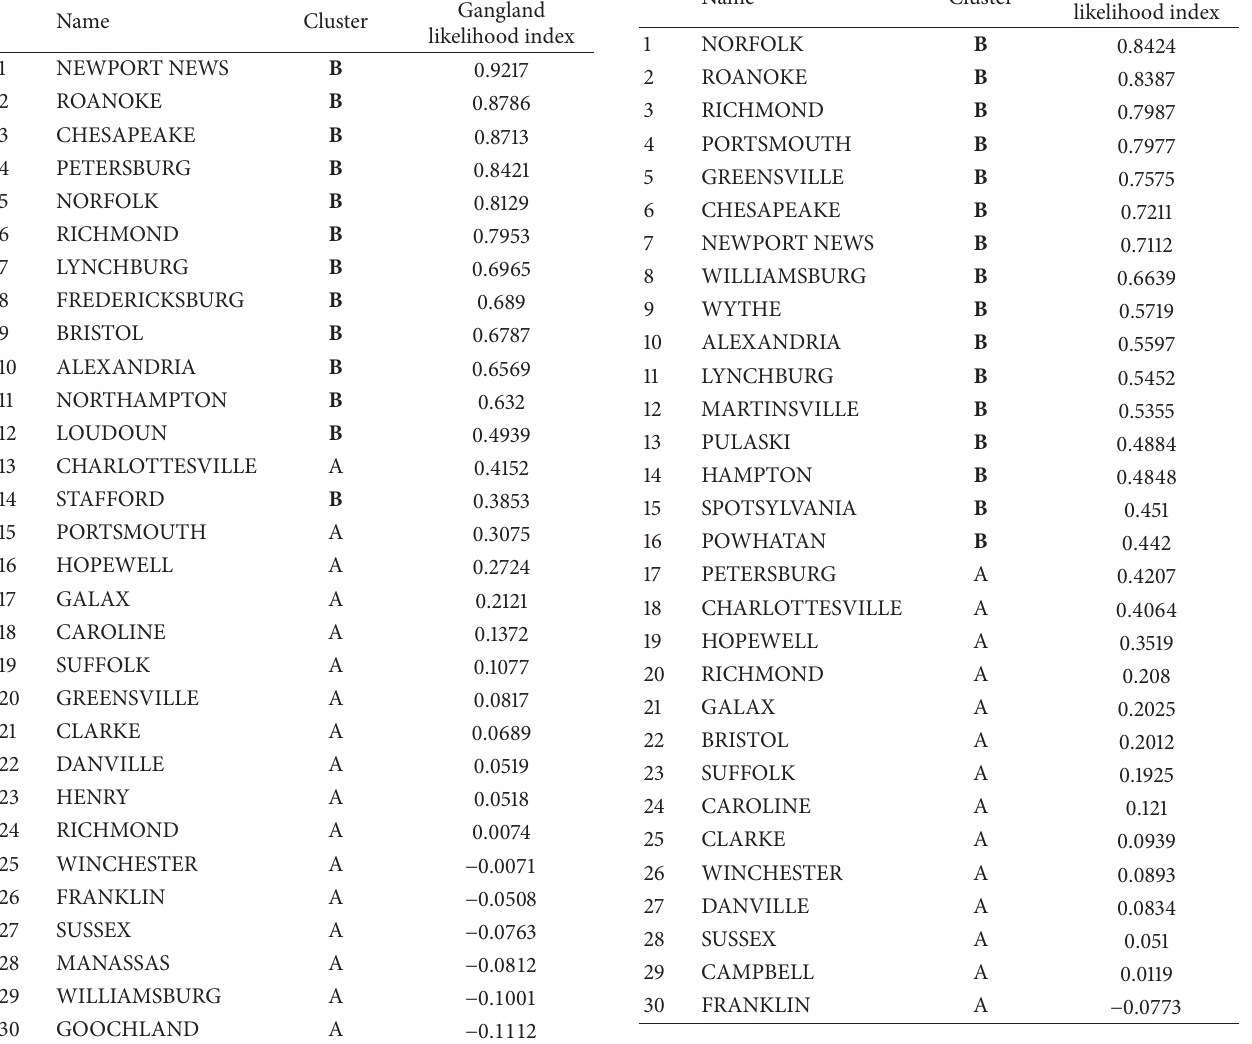
Table 9: Likelihood index and clustering for gangland (organized crime involvement).